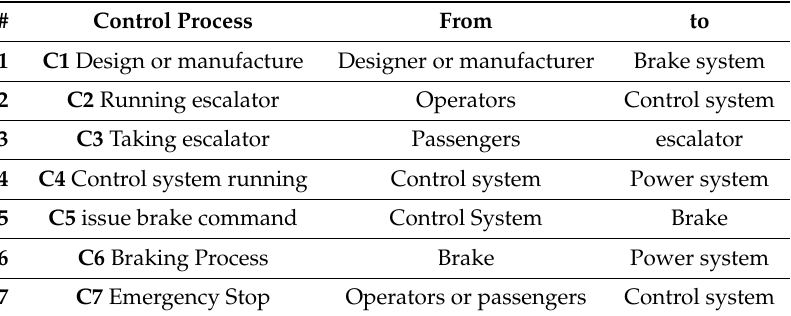
Table 3. Control process in Level